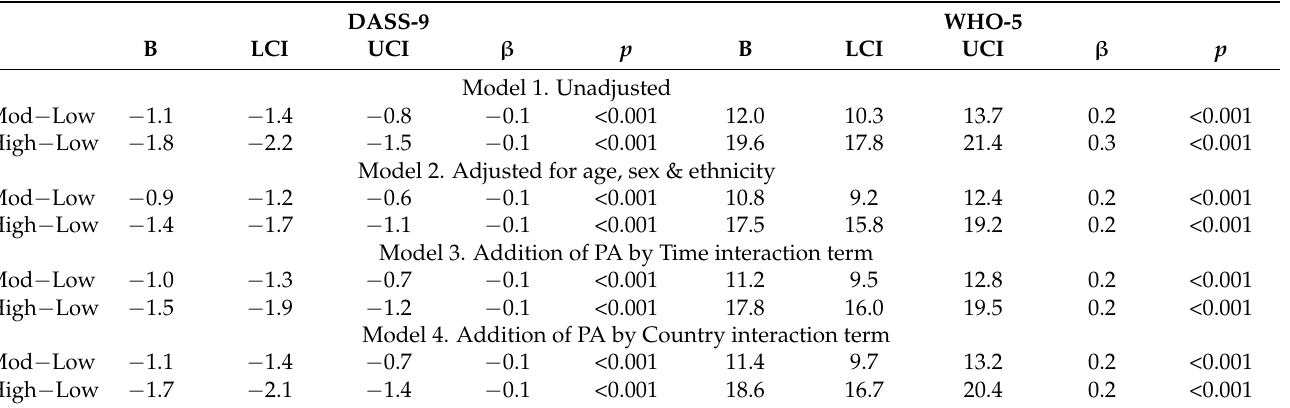
Table 3. Associations between subjectively measured physical activity (IPAQ-SF) with mental health (DASS-9) and well-being (WHO-5). Data presented are linear mixed-ef- fects model estimates. Specifically, simple effects for low vs. moderate- and low vs.